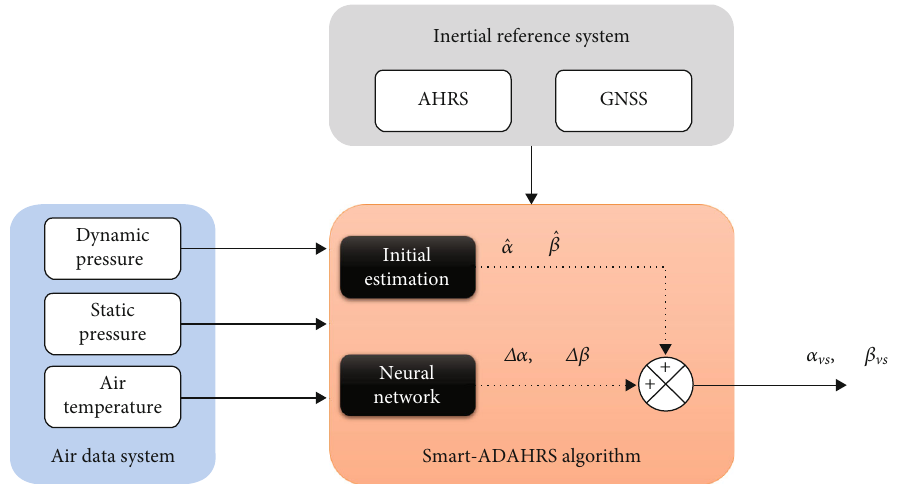
Figure 4: General schematic of the AoA estimation using the approach proposed in Equation